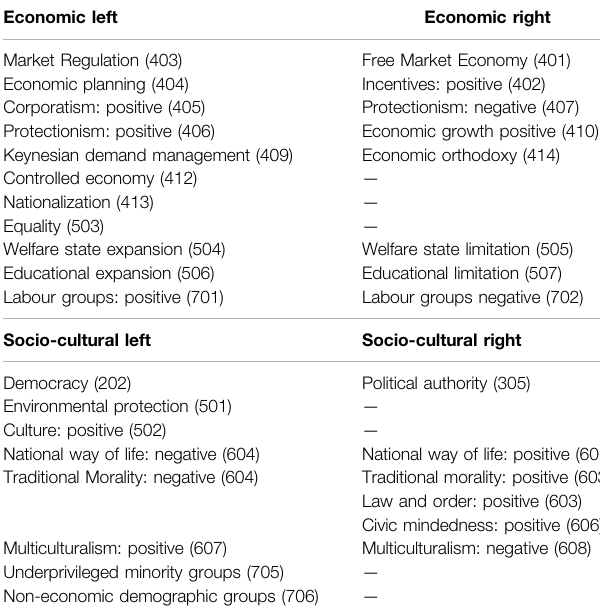
TABLE 5 | Issues used to de fi ne an economic and a socio-cultural dimension in Bakker and Hobolt (2013). Economic left Economic